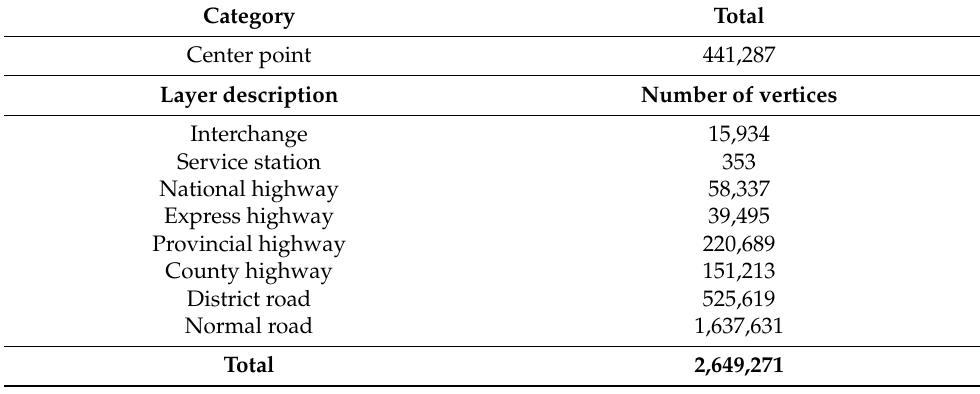
Table 1. Segment data.